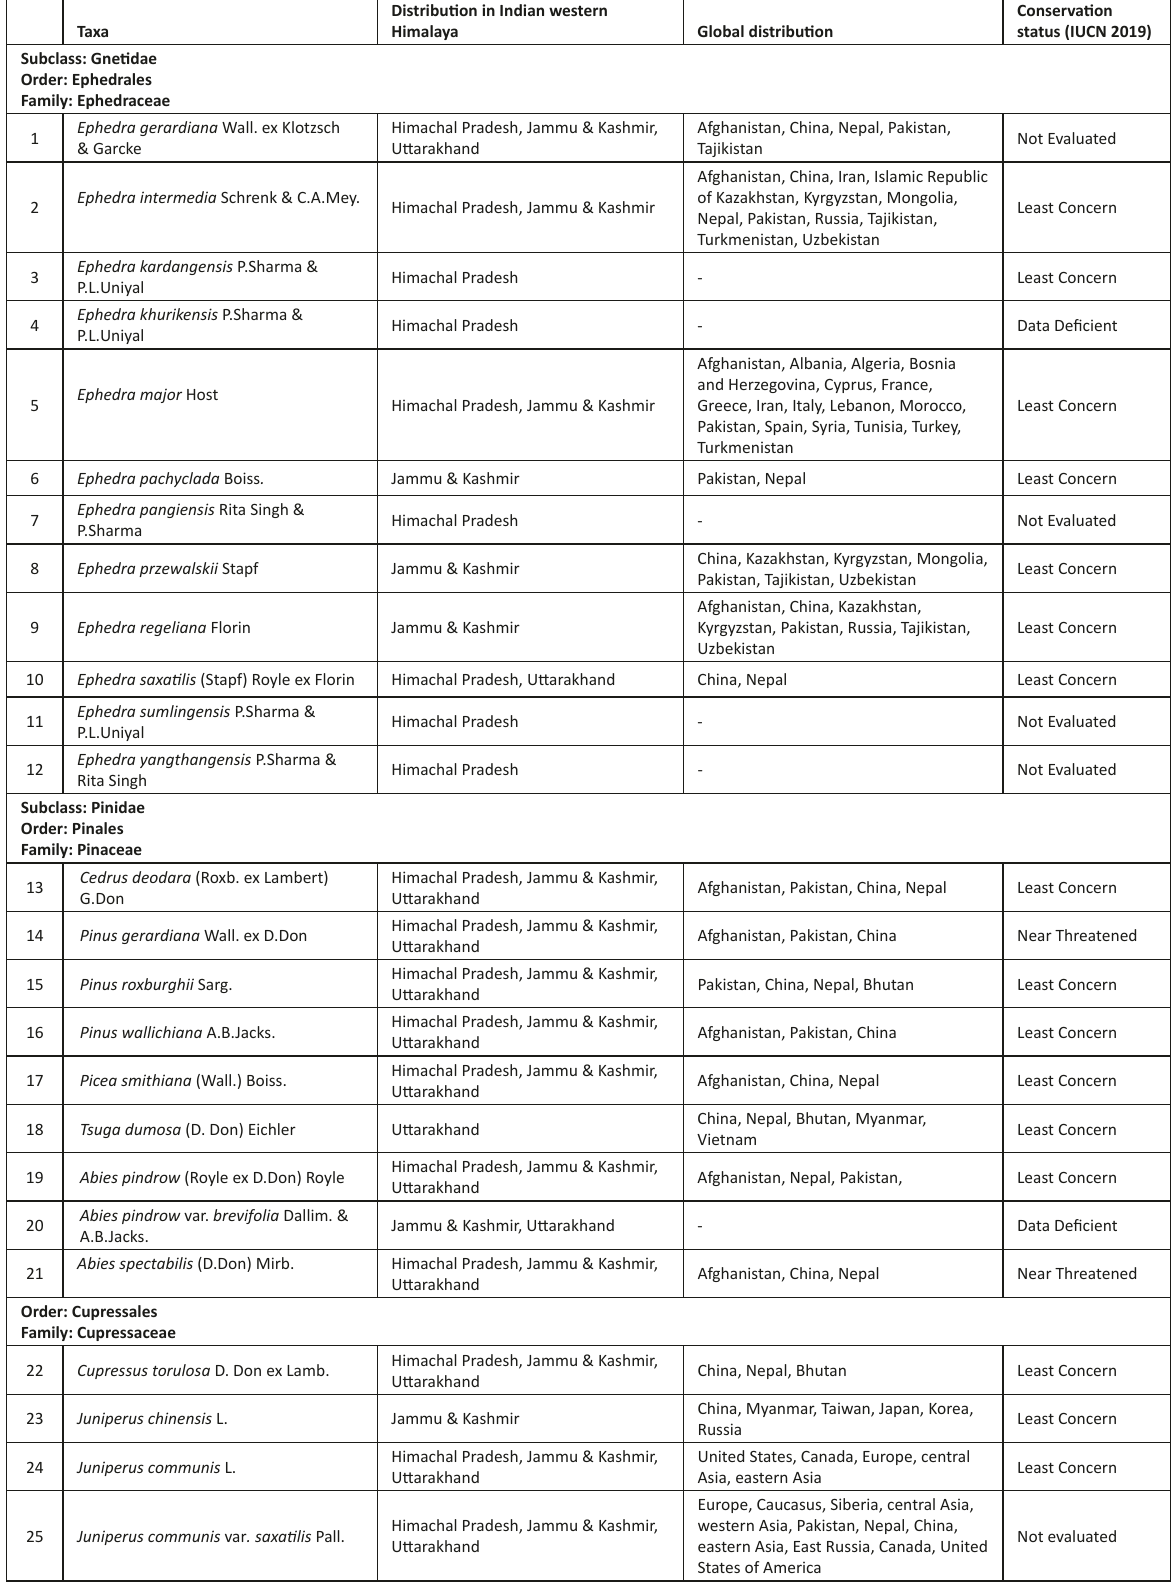
Table 1. Checklist of extant gymnosperms of the Indian western Himalaya.